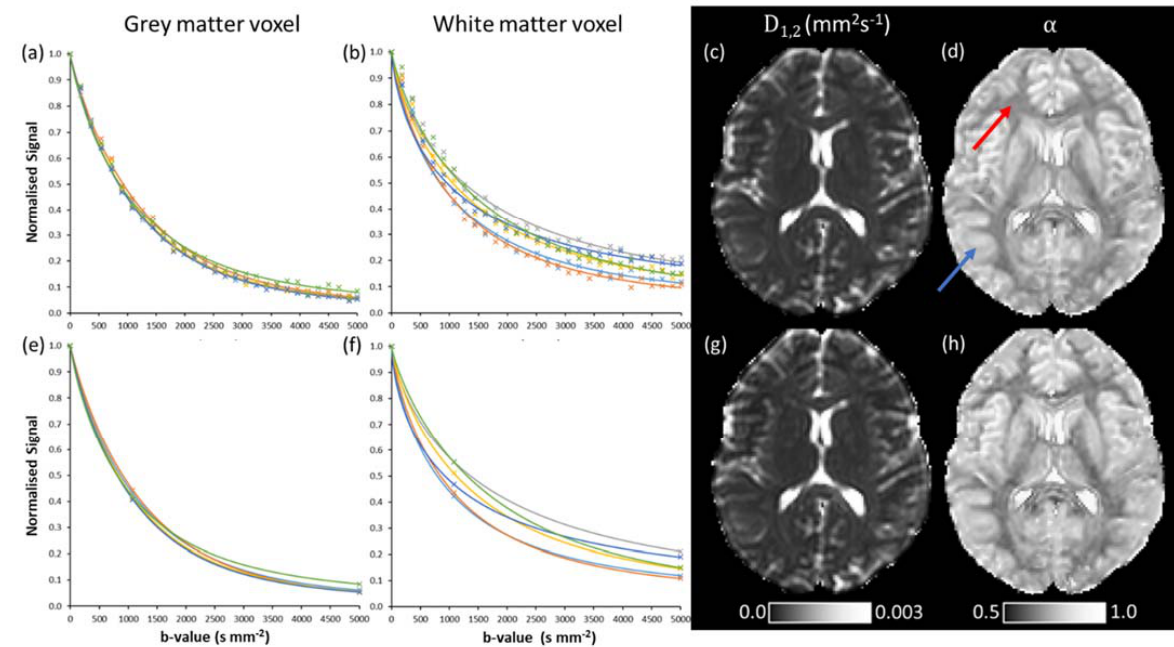
Figure 2. Quasi-diffusion model fits to experimental diffusion magnetic resonance imaging data acquired in the brain of a young, healthy subject (age 28 years). The top row shows the results of fitting the quasi-diffusion model to an acquisition of 29 b -values over the range 0 < b ≤ 5000 s mm − 2 , with the bottom row showing the results of fitting the quasi-diffusion model to 3 b -values, b = { 0,1080,5000 } s mm − 2 . All imaging data were acquired in 6 diffusion encoding directions at an effective diffusion time of ∆ = 35.9 ms. Normalised signal attenuation is shown for a grey matter voxel indicated by the blue arrow (graphs ( a , e )), and a white matter voxel indicated by the red arrow (graphs ( b , f )). Axial slices are shown for maps of mean D 1,2 (images ( c , g )) and mean α (images ( d , h